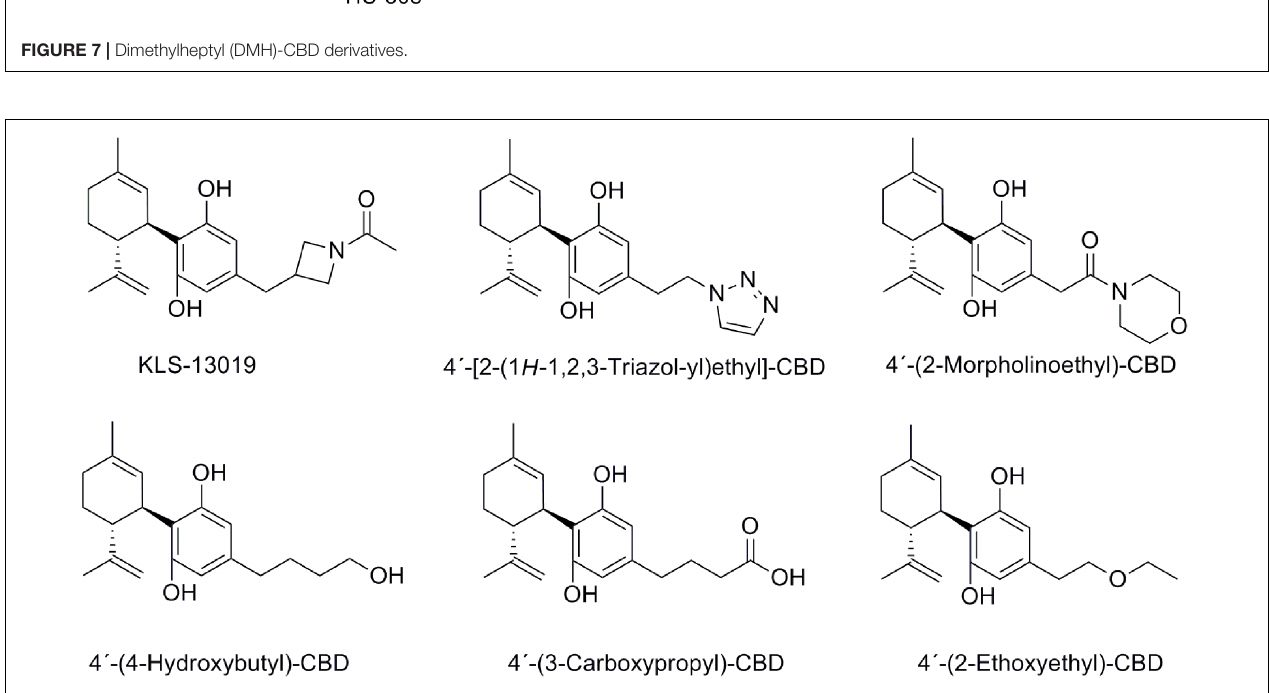
FIGURE 8 | Cannabidiol analogs modified on the C4 (cid:48) -alkyl chain.